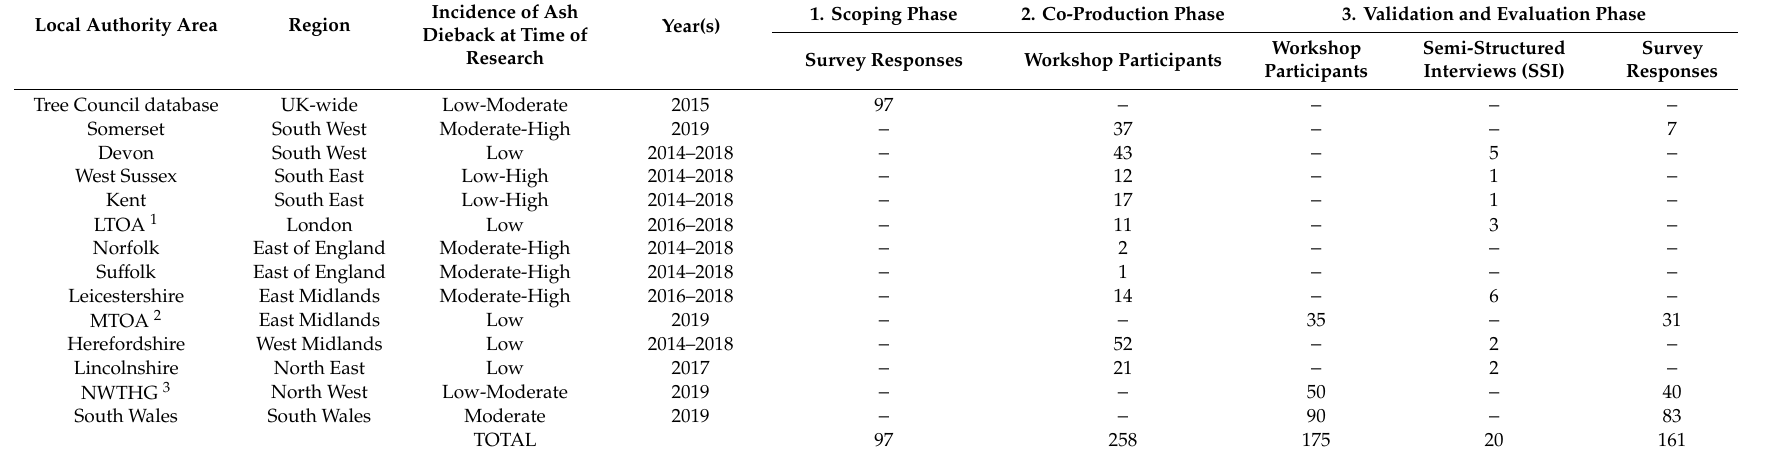
Table 1. Sources of evidence and numbers of participants in the participatory action research (PAR) process with local authorities between 2014–2019 (n = the numbers of local authority sta ff